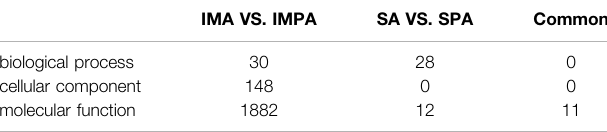
TABLE5| GOenrichmentanalysisofthetargetgenesofIncRNAsinintramuscular and subcutaneous adipocytes. IMA VS. IMPA